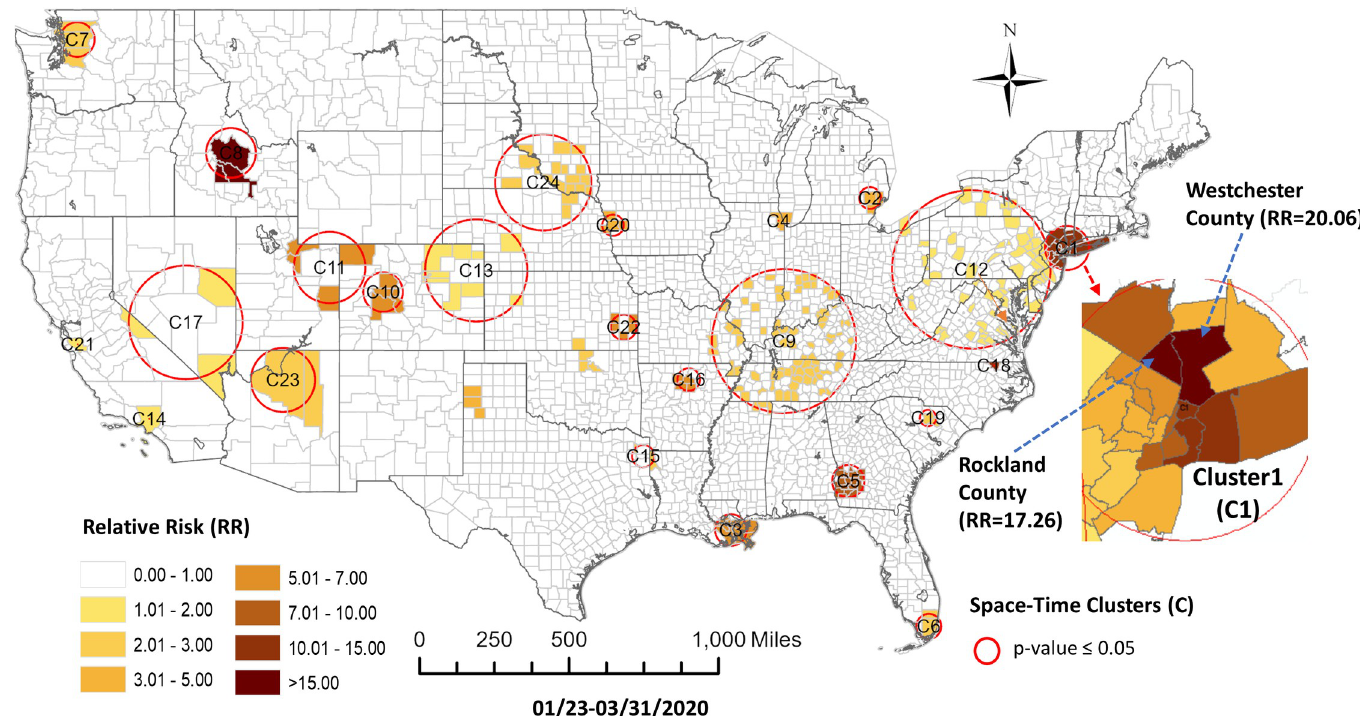
Fig 4. COVID-19 space-time scan statistic detected hotspots in the United States at county level through 3/31/2020.